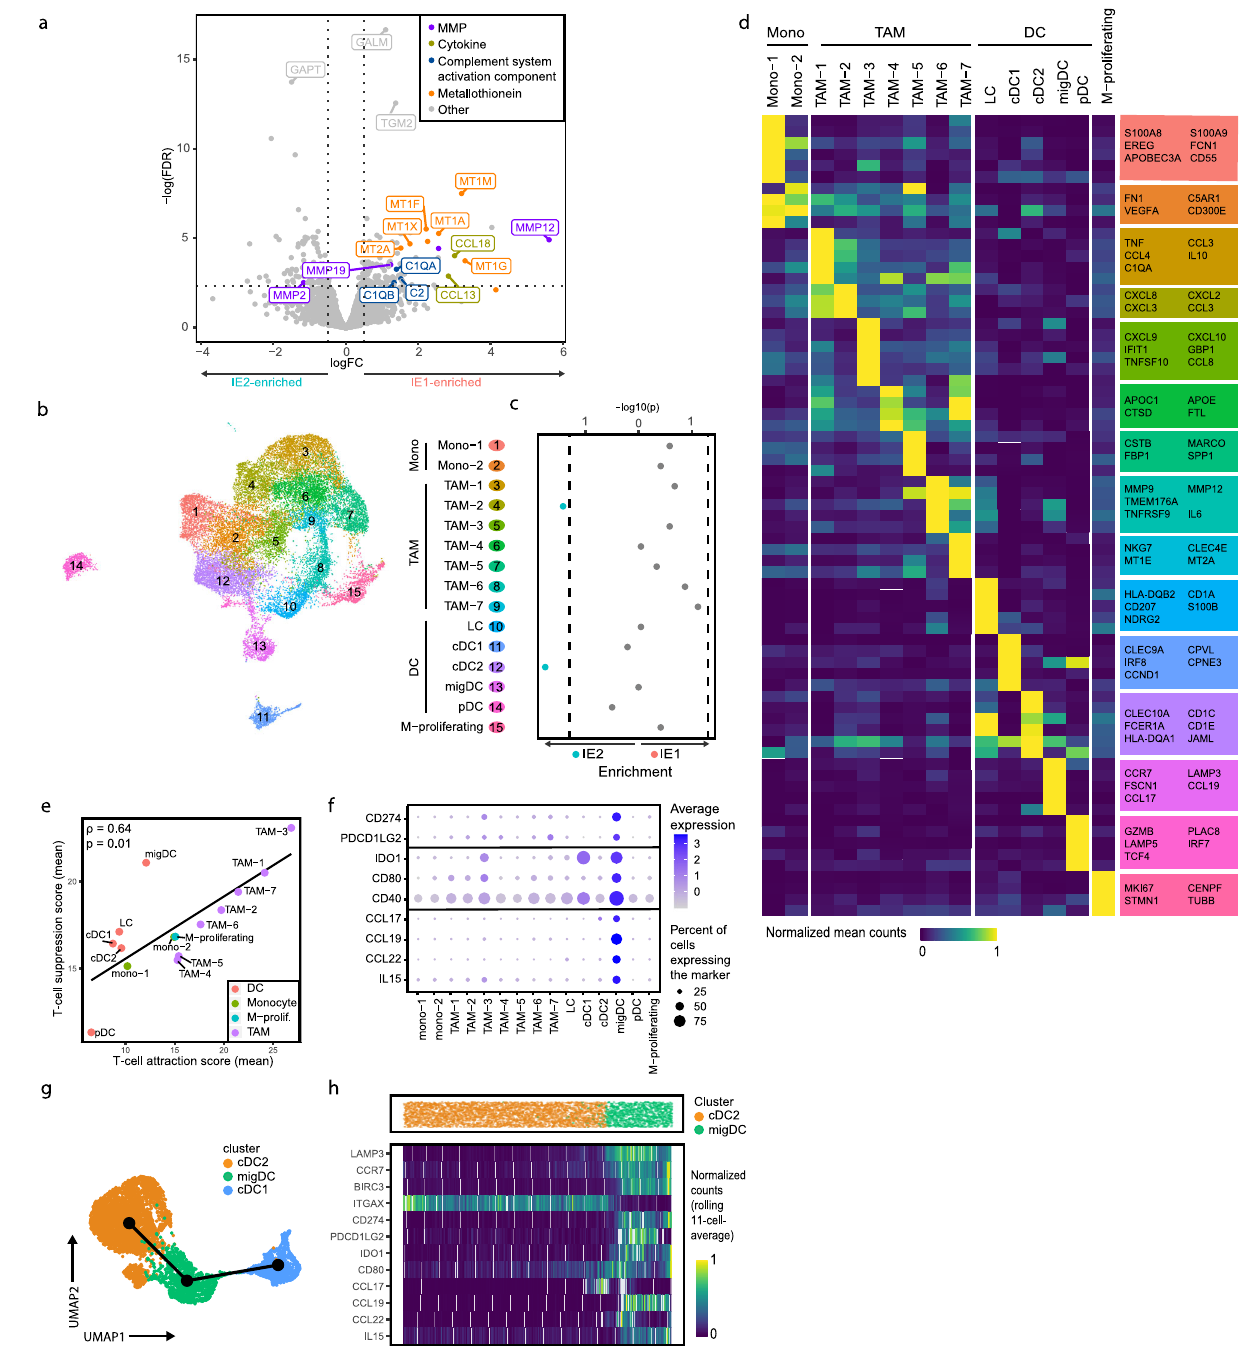
Fig. 4 | Myeloid cell phenotypes in exhausted immune environments indicate in fl ammation and T cell-suppressive potential. a Volcano plot showing differ- entialgene expressionbetweenmyeloidcellsof IE1and IE2samples in pseudobulk patient-averagedscRNA-seqdata.DashedlinesindicateanFDRof0.1andalogFCof 0.5. Genes are colored by functional group. b UMAP plot of scRNA-seq data from 26,000 myeloid cells colored by Seurat cluster and annotated by cell type. c Enrichment of cluster frequencies in IE1 and IE2 samples. Two-sided Wilcoxon ranksum testwasusedforstatisticalanalysisanddashed linesindicatea p valueof 0.05. d Heatmap showing normalized average single-cell expression of the top 10 differentially expressed genes for all myeloid cell clusters. Selected genes